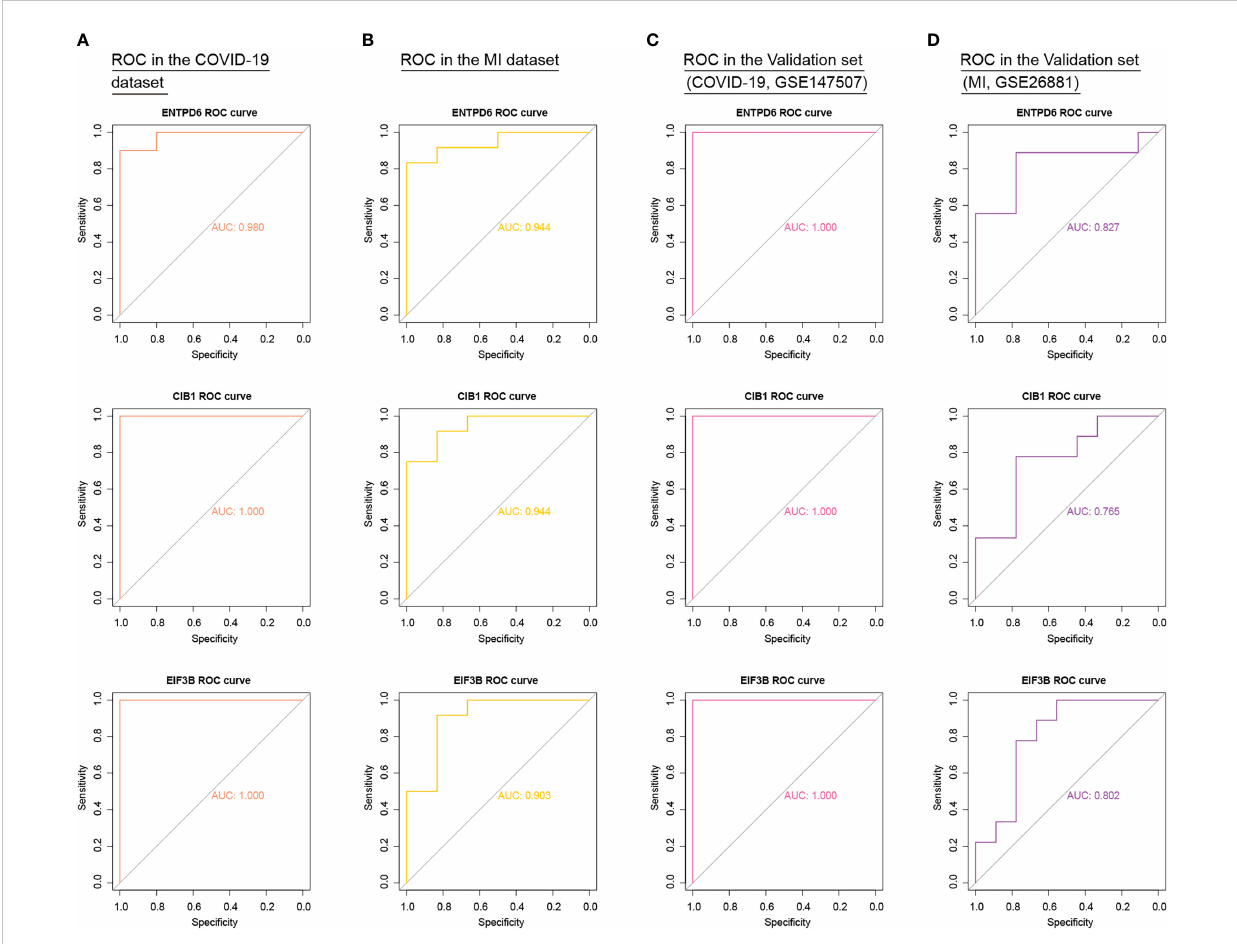
FIGURE 6 External validation of diagnostic values of three hub CORGs (ENTPD6, CIB1, and EIF3B) in COVID-19 dataset, MI dataset, and two independent validation sets. (A) ROC results of three hub CORGs in the COVID-19 dataset (AUC > 0.75). (B) ROC results of three hub CORGs in the MI dataset (AUC > 0.75). (C) ROC results of three hub CORGs in a validation set (COVID-19, GSE147507, AUC > 0.75). (D) ROC results of three hub CORGs in a validation set (MI, GSE26881, AUC > 0.75). CORGs, COVID-19-related differentially expressed genes; MI, male infertility; ROC, receiver operating characteristic; AUC, area under the